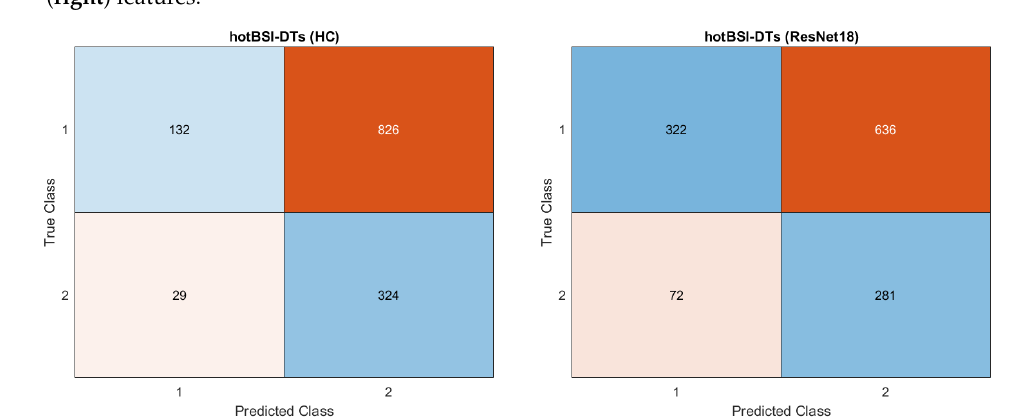
Figure A4. Confusion matrices for the hotBSI-DTs trained with handcrafted ( left ) and ResNet18 ( right )